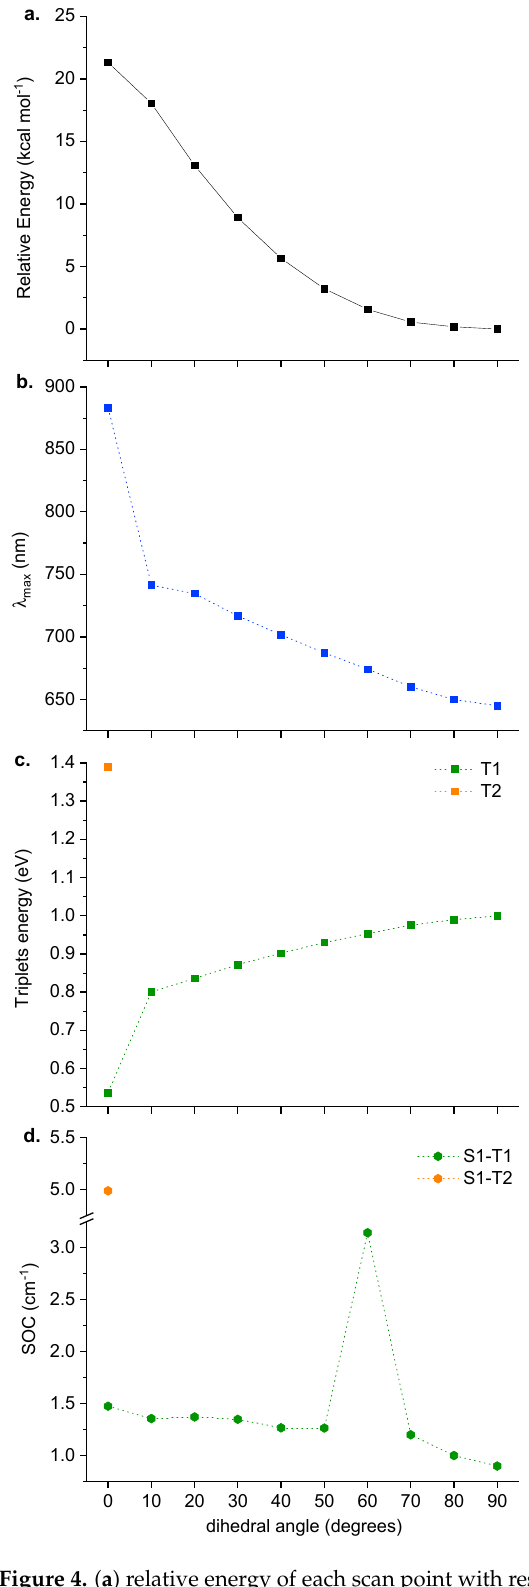
Figure 4. ( a ) relative energy of each scan point with respect to the most stable semi-relaxed structure, ( b ) maximum absorption wavelength, ( c ) triplet states energy and ( d ) SOCs computed for the accessible ISC channels.